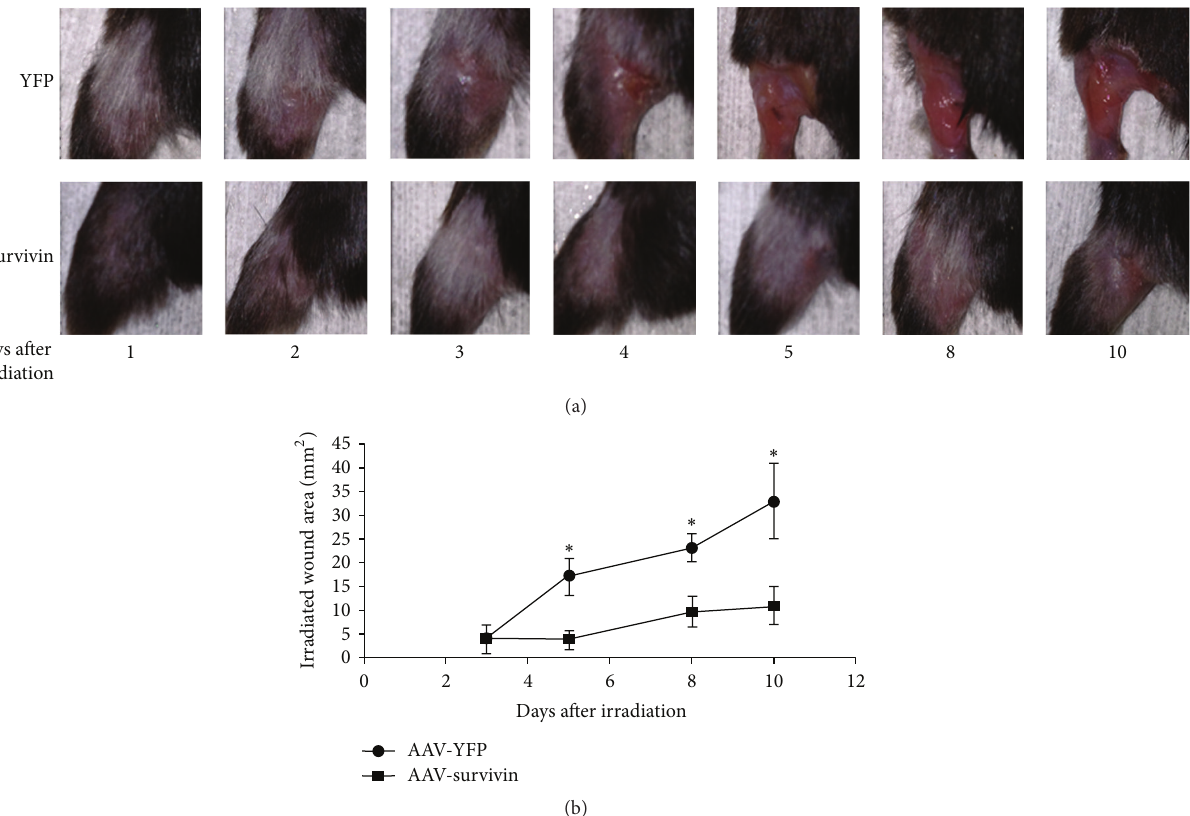
Figure 2: Mice treated with rAAV-survivin showed fewer signs of damage to the skin and surrounding tissue following 50 Gy of radiation exposure. Mice were monitored daily following the ten-day radiation protocol (a). Both YFP and survivin treated mice initially showed hair loss; however, by five days after the last dosage, there was a significant difference between the two groups in terms of the area of skin ulceration and impaired wound healing (b). Student’s 𝑡 -test was used to compare the groups and 𝑝 ≤ 0.05 demonstrated a significant result. Data are mean ± s.d.; 𝑛 = 5 per group. Student’s 𝑡 -test: 𝑝 < 0.01 at five, eight, and ten days after radiation exposure. ∗ indicates significance.